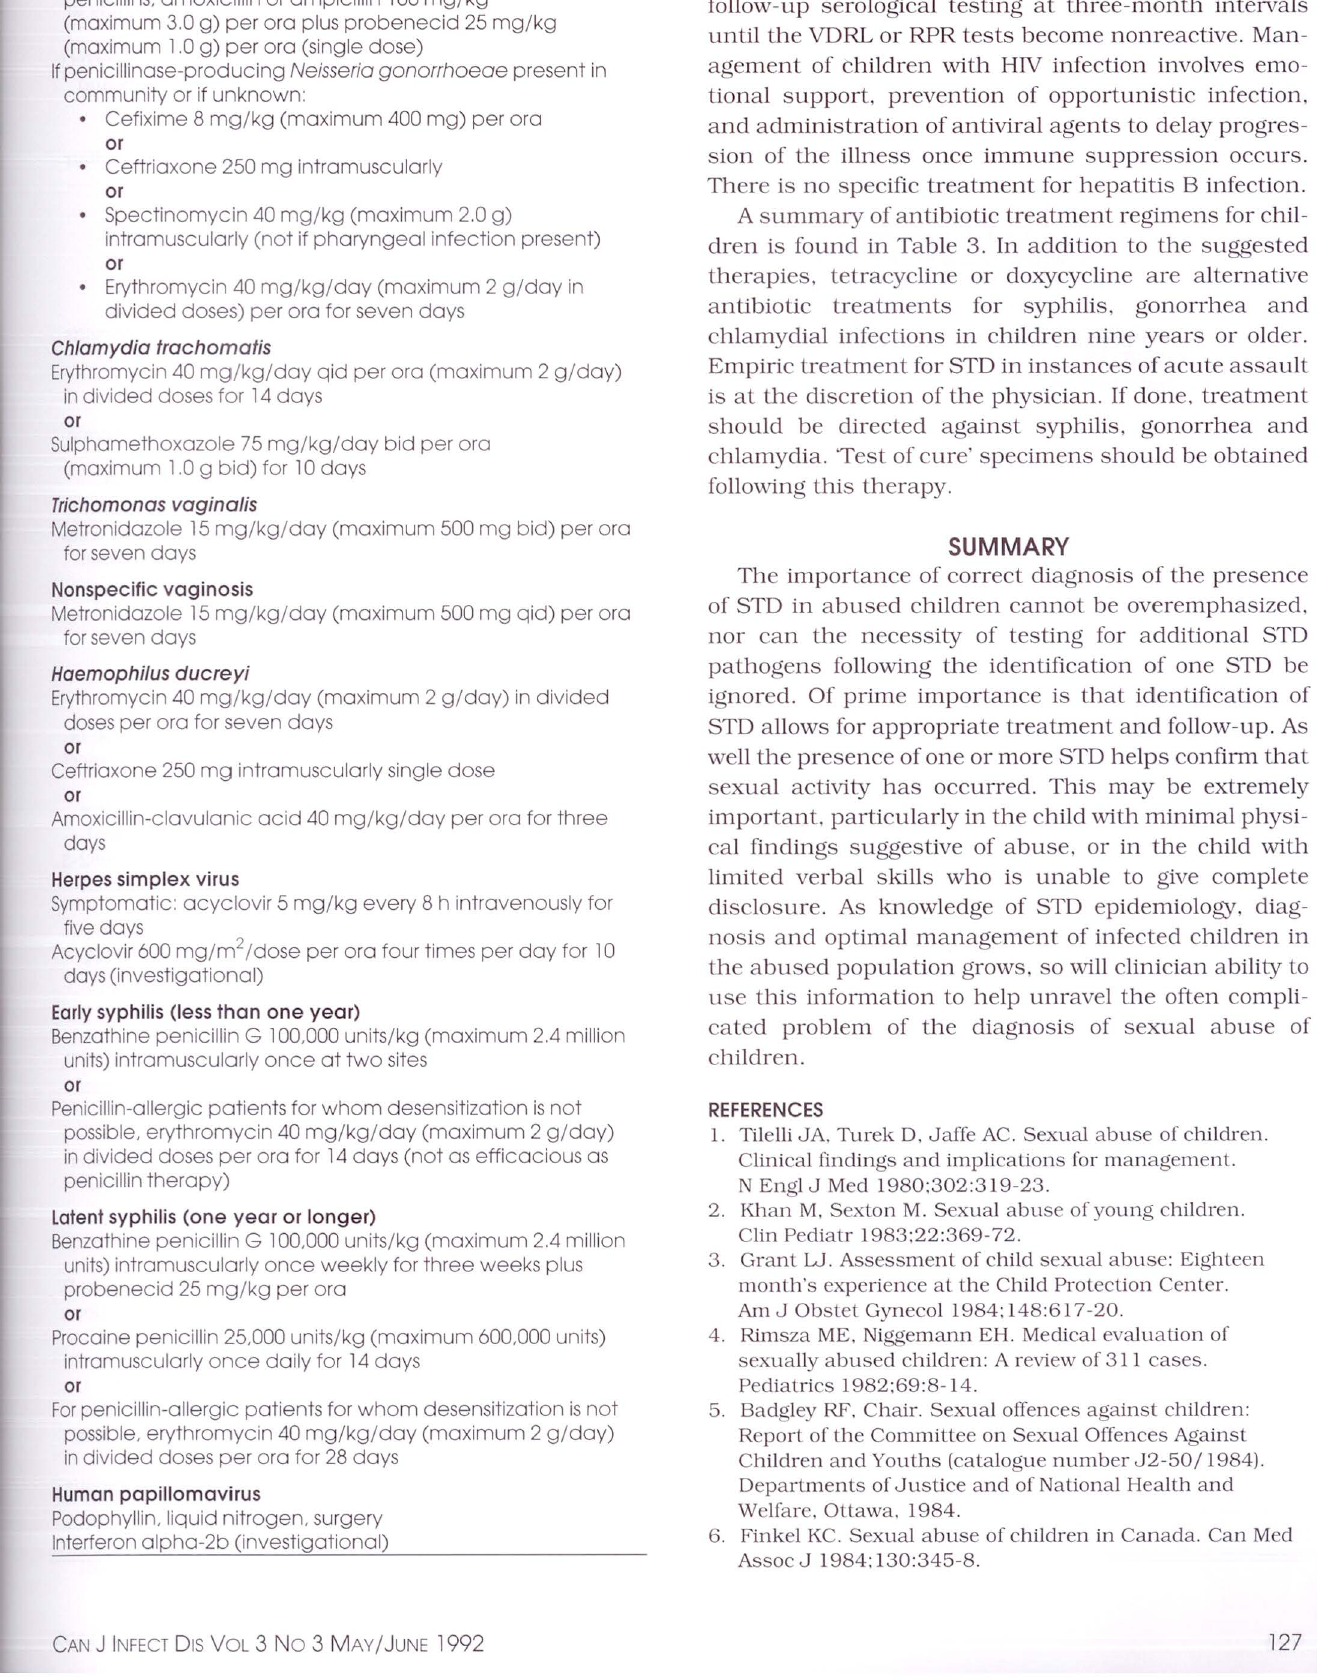
Treatment of sexually transmitted pathogens in children Neisseria gonorrhoeae If the organism has been isolated and found to be sensitive to penicillins, amoxicillin or ampicillin l 00 mg/kg (maximum 3.0 g) per ora plus probenecid 25